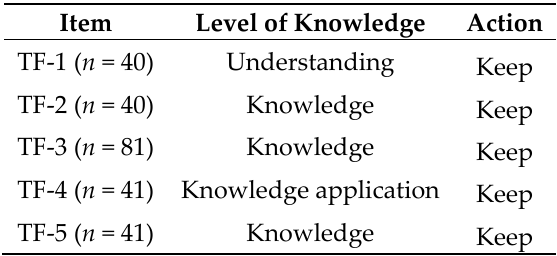
Table 6. Decisions from the analysis of the